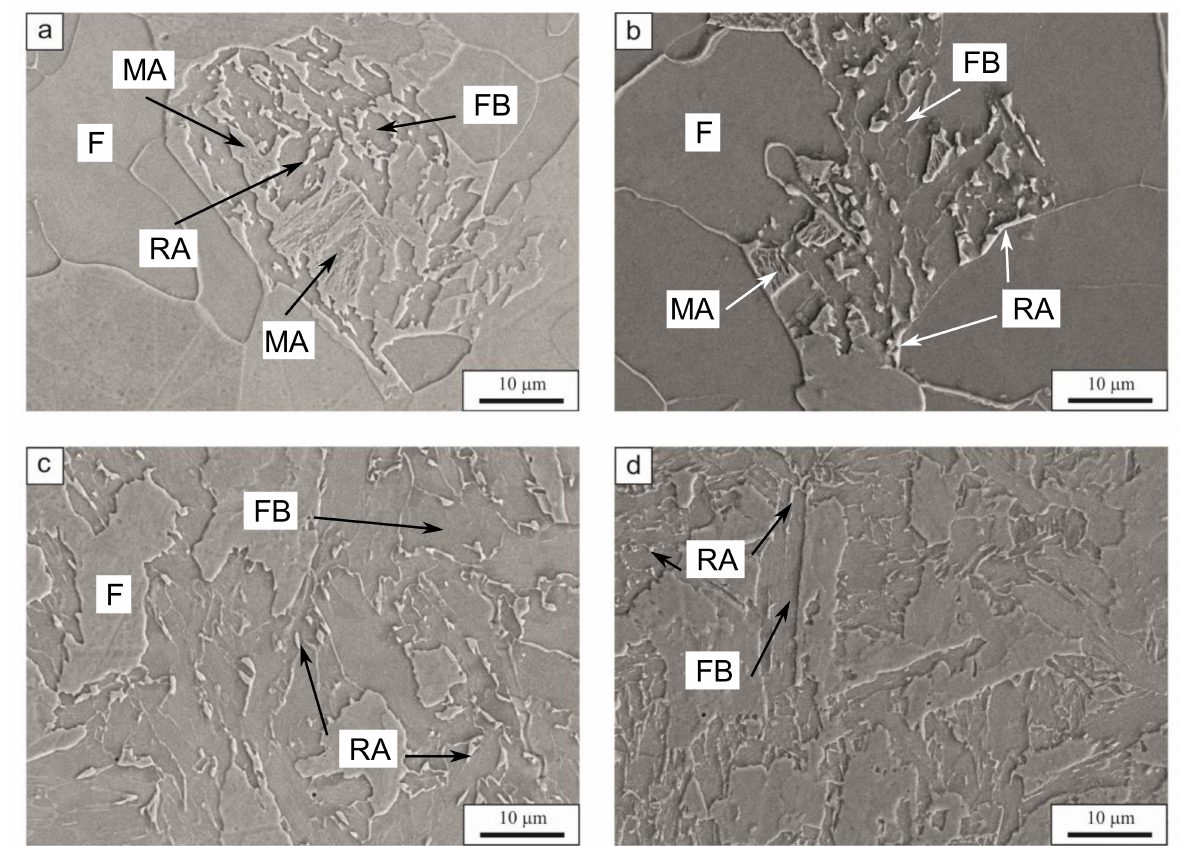
Figure 6. The scanning electron microscopy micrographs of the selected cooling variants: ( a ) 0.1 ◦ C/s, ( b ) 1 ◦ C/s, ( c ) 8 ◦ C/s, ( d ) 60 ◦ C/s; F—ferrite, FB—bainitic ferrite, MA—martensitic-austenitic island, RA—retained